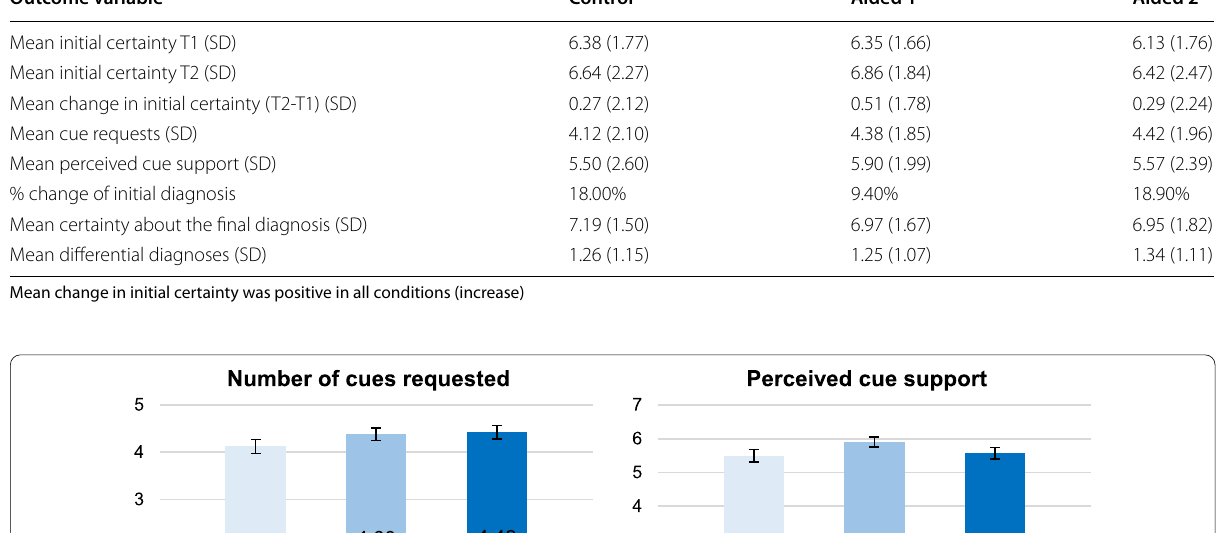
Table 4 Descriptive statistics by condition Outcome variable